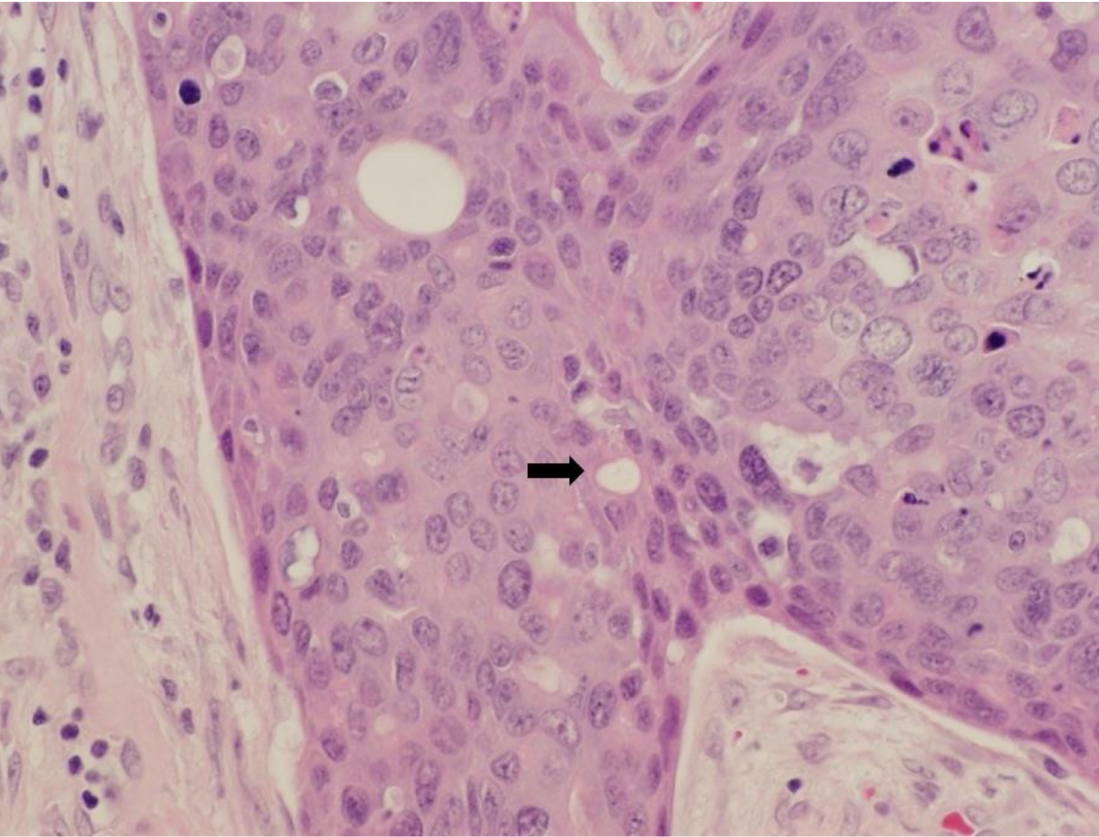
Figure 1. Photomicrograph taken at high power showing invasive porocarcinoma with luminal-like spaces within epithelial nests (40 ×